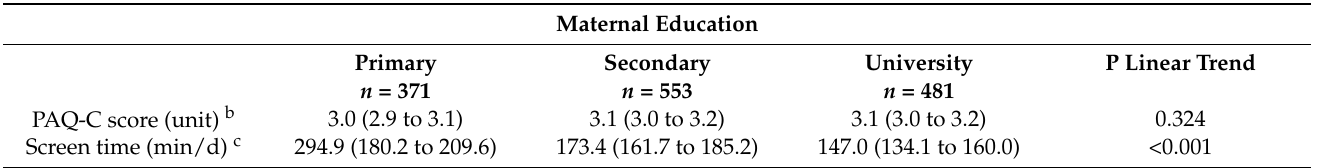
Table 2. Association of baseline maternal education with child’s physical activity and screen time at follow-up a .